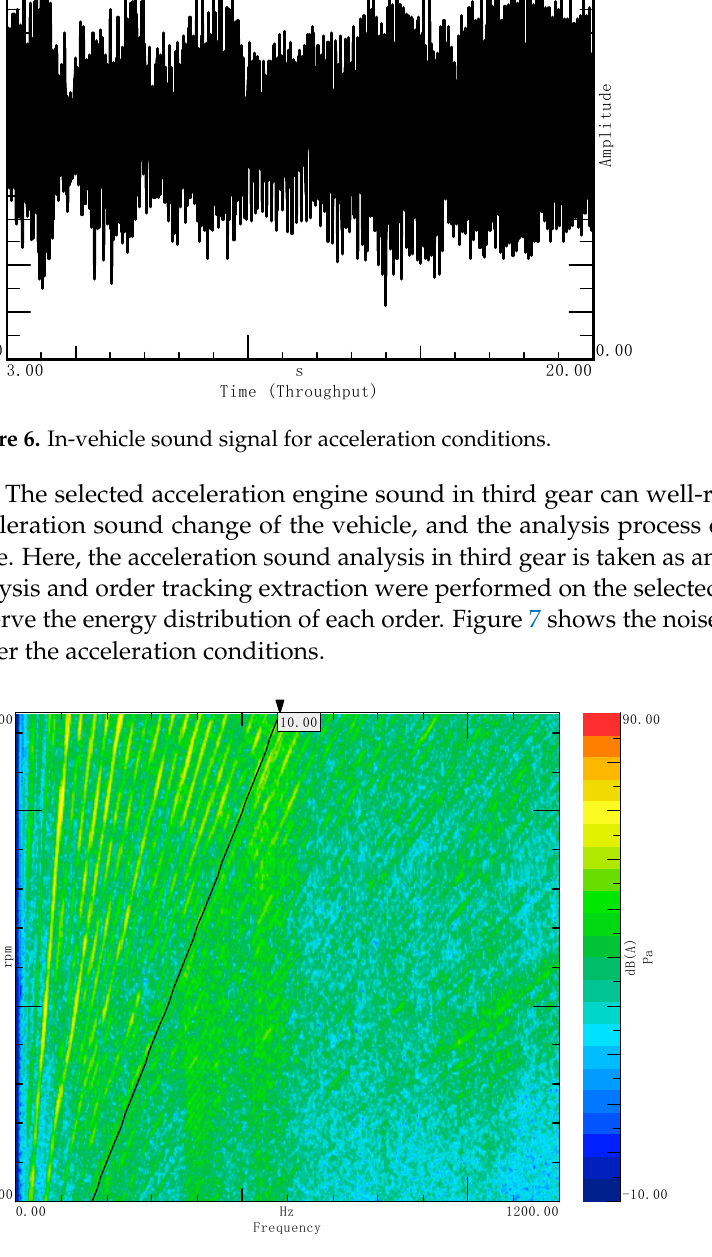
Figure 7. Acceleration noise spectrum in the vehicle under acceleration